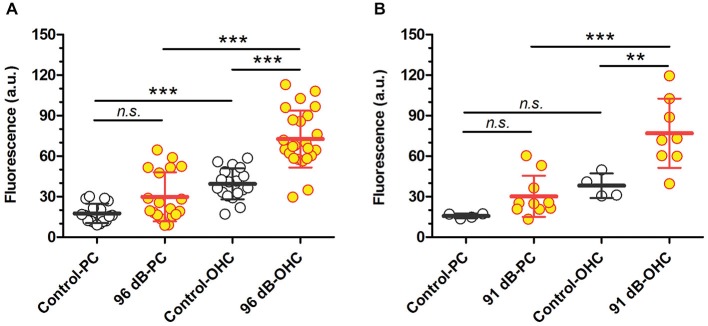
Loud sound-enhanced GTTR uptake in two cell populations from the organ of Corti after 96 dB SPL (A) or 91 dB SPL (B) sound exposure. (A) Sound-enhanced GTTR fluorescence was observed in a fraction of pillar cells from the middle and basal cochlear regions of 2 out of 4 cochleae after exposure to WBN at 96 dB SPL for 18 h over 3 days. In contrast, enhanced GTTR fluorescence was observed in the majority of OHCs adjacent to pillar cells in the same regions. n = 3 for control cochleae, n = 4 for loud sound-treated cochleae; up to six sites were examined for each cochlea and averaged from at least 16 pillar cells or OHCs. (B) Sound-enhanced GTTR fluorescence was observed in a few pillar cells from the middle cochlear regions after exposure to WBN at 91 dB SPL for 18 h over 3 days. In contrast, enhanced GTTR fluorescence was observed in the majority of OHCs adjacent to pillar cells in the same regions. n = 2 for control cochleae, n = 4 for sound-treated cochleae; up to six sites examined for each cochlea and averaged from at least 9 pillar cells or OHCs. For both sound levels, sound-enhanced GTTR uptake is only statistically significant in OHC populations, using Tukey’s multiple comparison test from one-way ANOVA. ***p < 0.001, **p < 0.01, n.s. = not significant. Mean and s.d. are superimposed on each dataset.